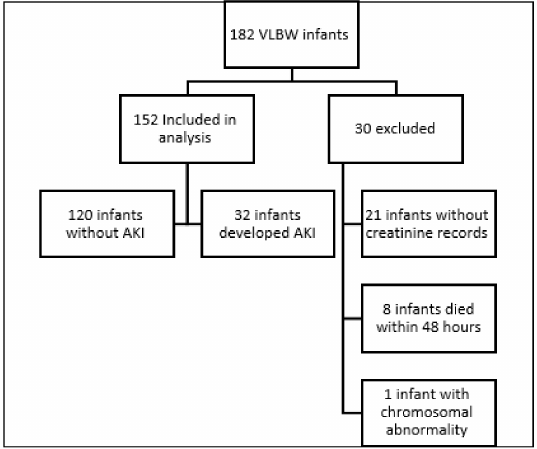
Figure 1. Study flow chart. VLBW—Very low birth weight. AKI—Acute kidney injury.